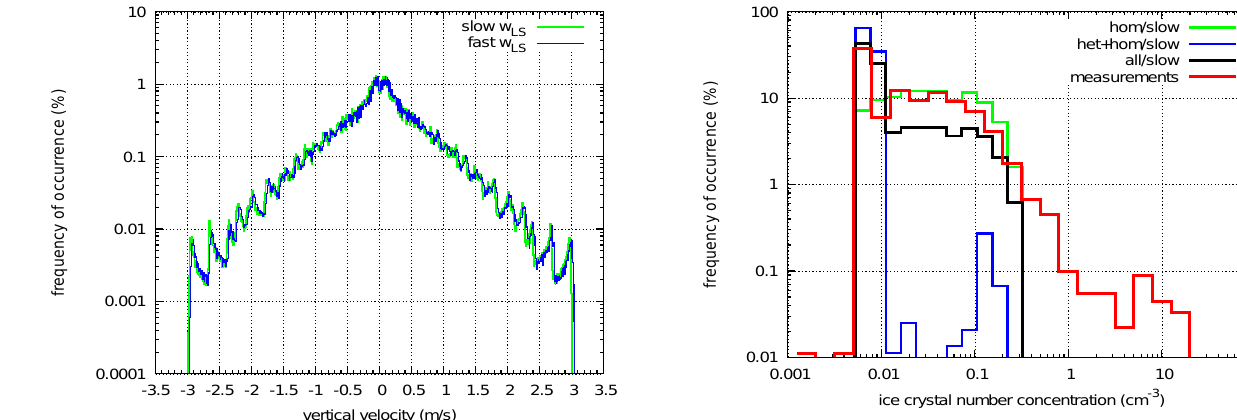
Fig. 9. Vertical velocity from simulations with pure homogeneous freezing in very slow ( w LS ≤ 1cms − 1 , green) and faster ( w LS > 1cms − 1 , blue) large-scale motions. The absolute values and the distributions are nearly equal, except for the shift of about 1w ∼ 0 . 03ms − 1 , given by the large-scale vertical velocity w LS .